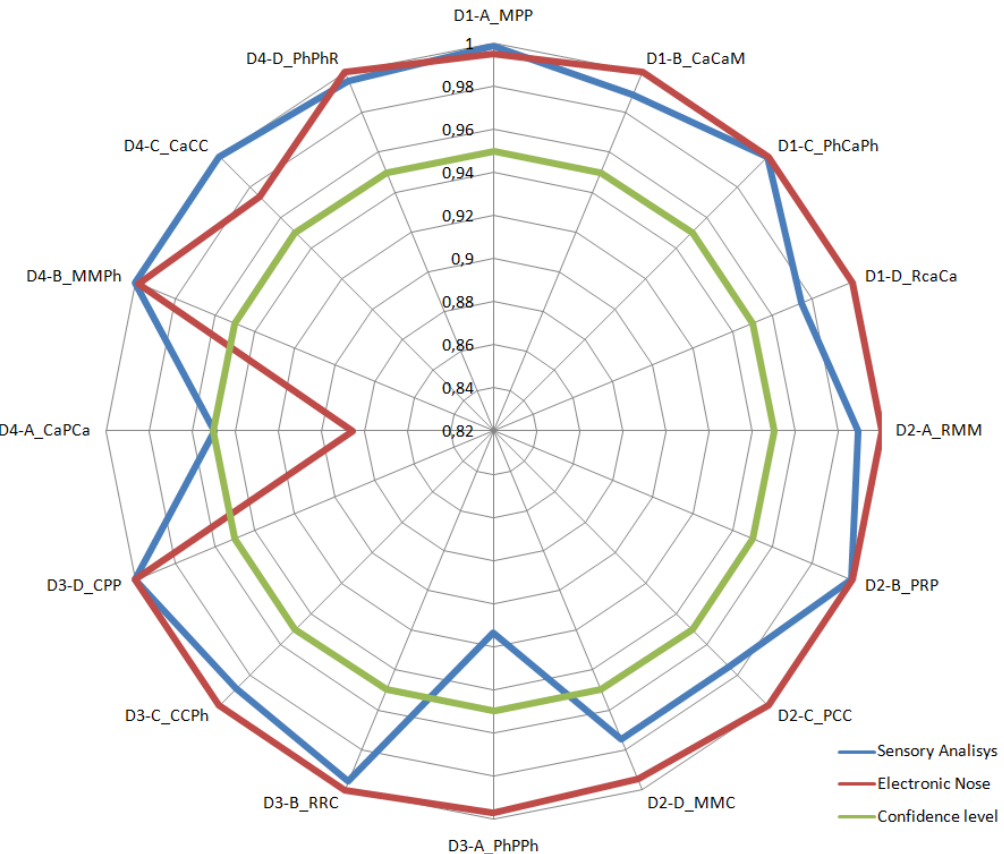
Figure 11. Comparison of the results of the triangular sensory test to those obtained by the electronic nose.